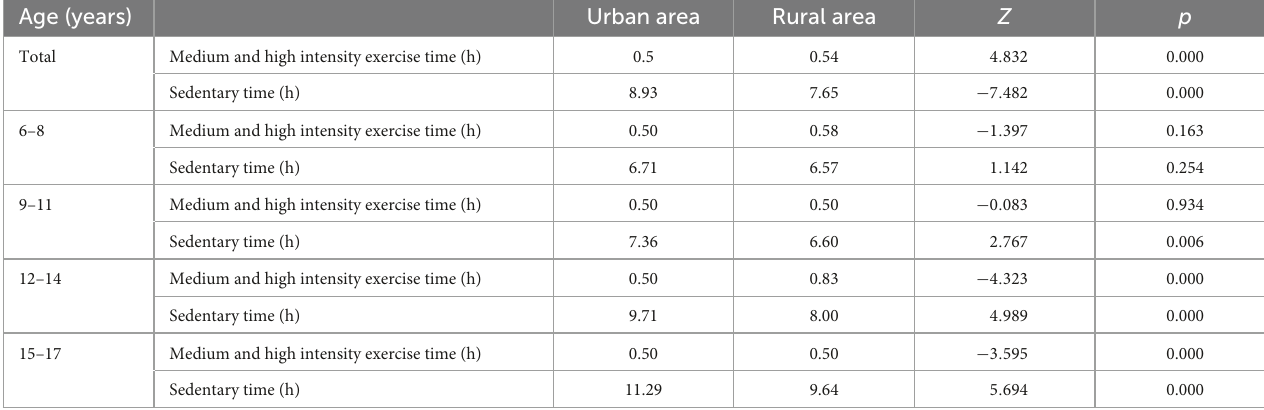
TABLE 3 Medium and high intensity exercise time and sedentary time of urban and rural